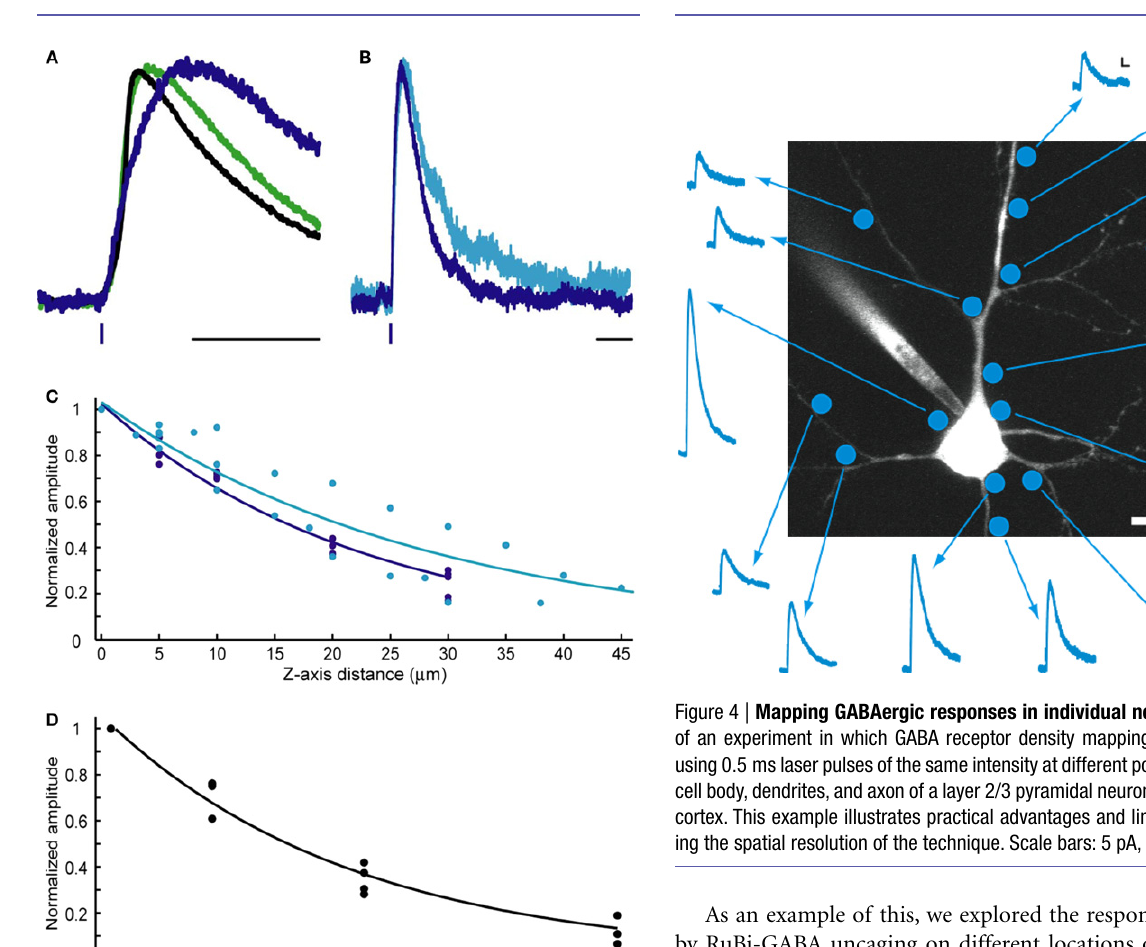
and (D) show single exponential fi ts of the data.